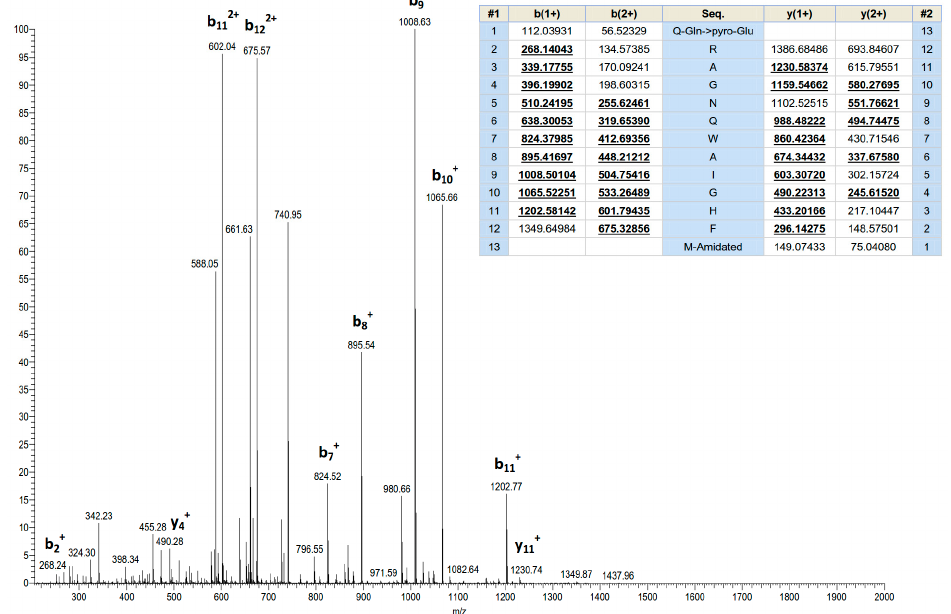
Figure 2. MS/MS fragmentation sequencing spectra of the bioactive peptide (ranatensin-HL) identified in the HPLC fraction of Hylarana latouchii skin secretion. Panel shows predicted singly and doubly charged b -ions and y -ions arising from MS/MS fragmentation. Observed ions are underlined and in bold typeface.